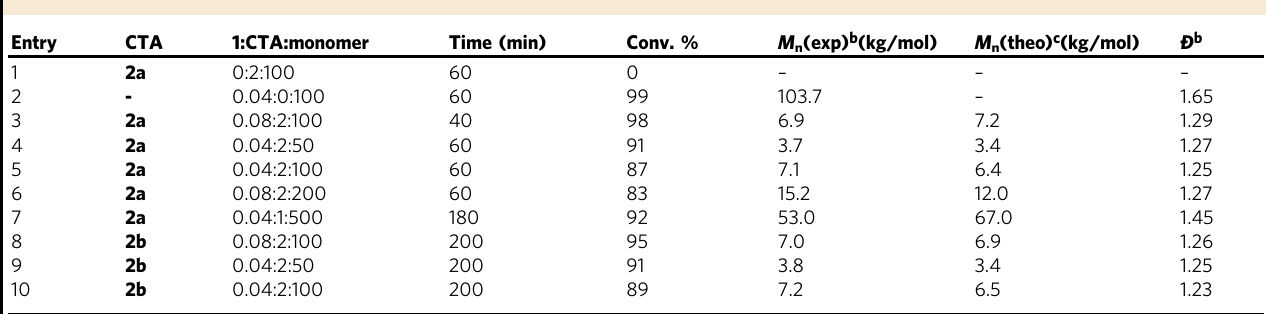
Fig. 2 Characterizations of OPC 1 and photoelectron transfer between OPC 1 and CTA 2a. a UV absorption spectrum of 1 . b The cyclic voltammogram of 1 . c Fluorescence changes of photocatalyst 1 with the addition of 2a . d Steady-state electron spin resonance spectrum of 1 with 2a under 532 nm irradiation. Table 1 Visible light-controlled living cationic polymerization of p -MOS a